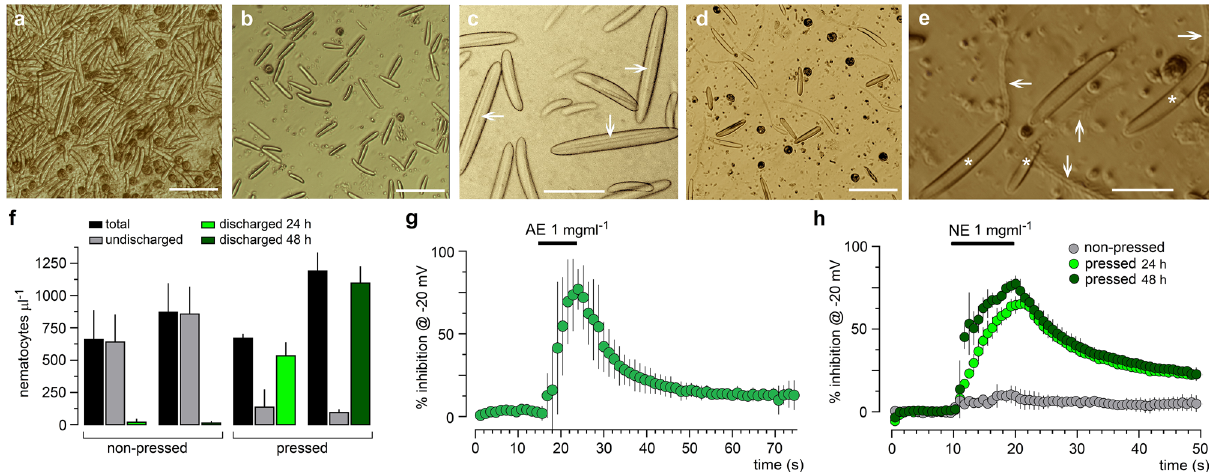
Figure 4. Nematocyst isolation and discharge using the French press cell disruption homogenizer. ( a ) Samples obtained from whole B. annulata anemone homogenate. ( b,c ) Samples recovered after 48 h following the Bloom’s method showing mainly undischarged nematocysts. Arrows in ( c ) signal typical images of twisted tubules in the undischarged nematocysts lumen. ( d,e ) Samples as in ( b ) after being processed through the French press at 6.2 × 10 7 Pa, that provided mainly discharged nematocysts. Asterisks in ( e ) signal the nematocysts empty capsules and arrows indicate ejected tubules (bar = 50 μm in ( a,b,d ); bar = 20 μm in ( c,d )). ( f ) Quantification of total (black columns), undischarged (gray columns), and discharged nematocysts (green columns) (per μl), for both non-pressed and pressed preparations in samples obtained by the Bloom’s method either after 24 h (light green) or 48 h (dark green) (mean ± S.D.; *p < 0.05 for comparisons between pressed vs. non-pressed). ( g ) Typical effect of AE (1 mg ml −1 ) on neuronal I Nav response at − 20 mV (n = 6) using the same protocol as in Fig. 3. ( h ) A group of anemones from the same batch was processed by the Bloom’s method and pressed either after 24 or 48 h, and the corresponding extracts were assayed on the neuronal I Nav activated at − 20 mV (light and dark green, respectively). In gray is shown the lack of effect of the non-pressed 48 h sample. Individual data points in ( g,h ) represent the mean ± S.D. from 4 to 5